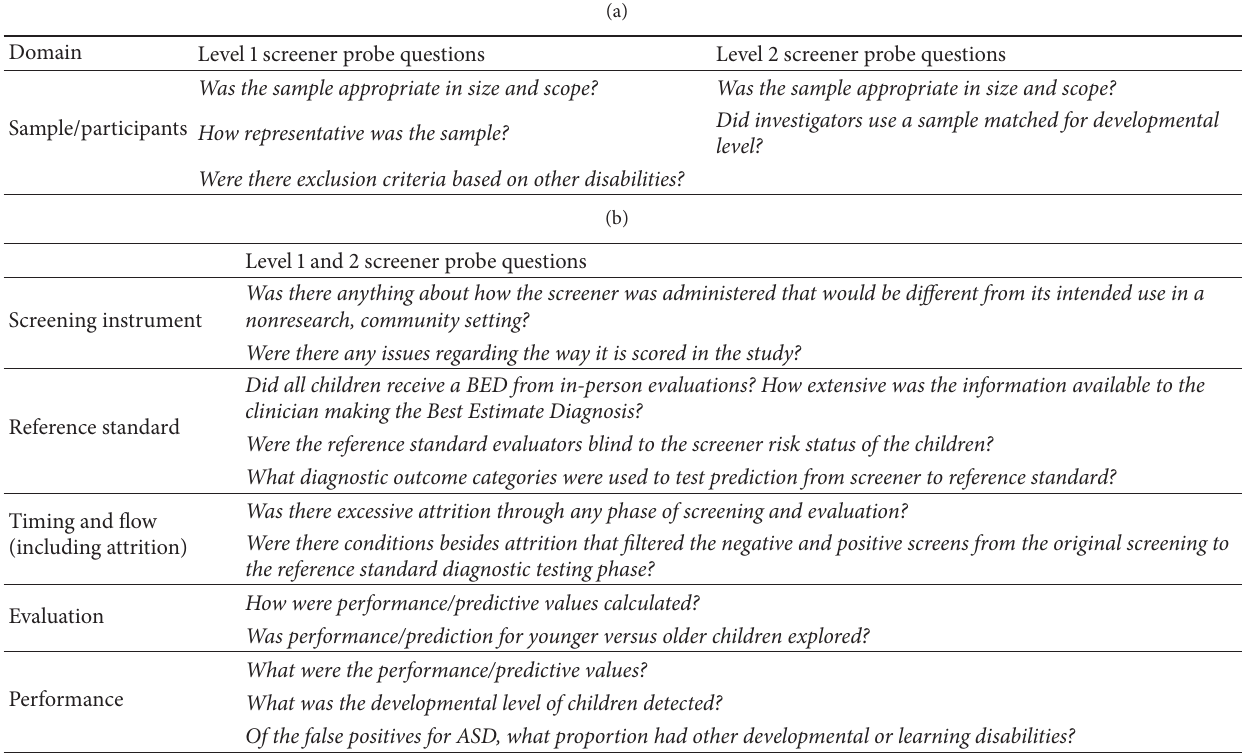
Table 1: Review domains and related probe